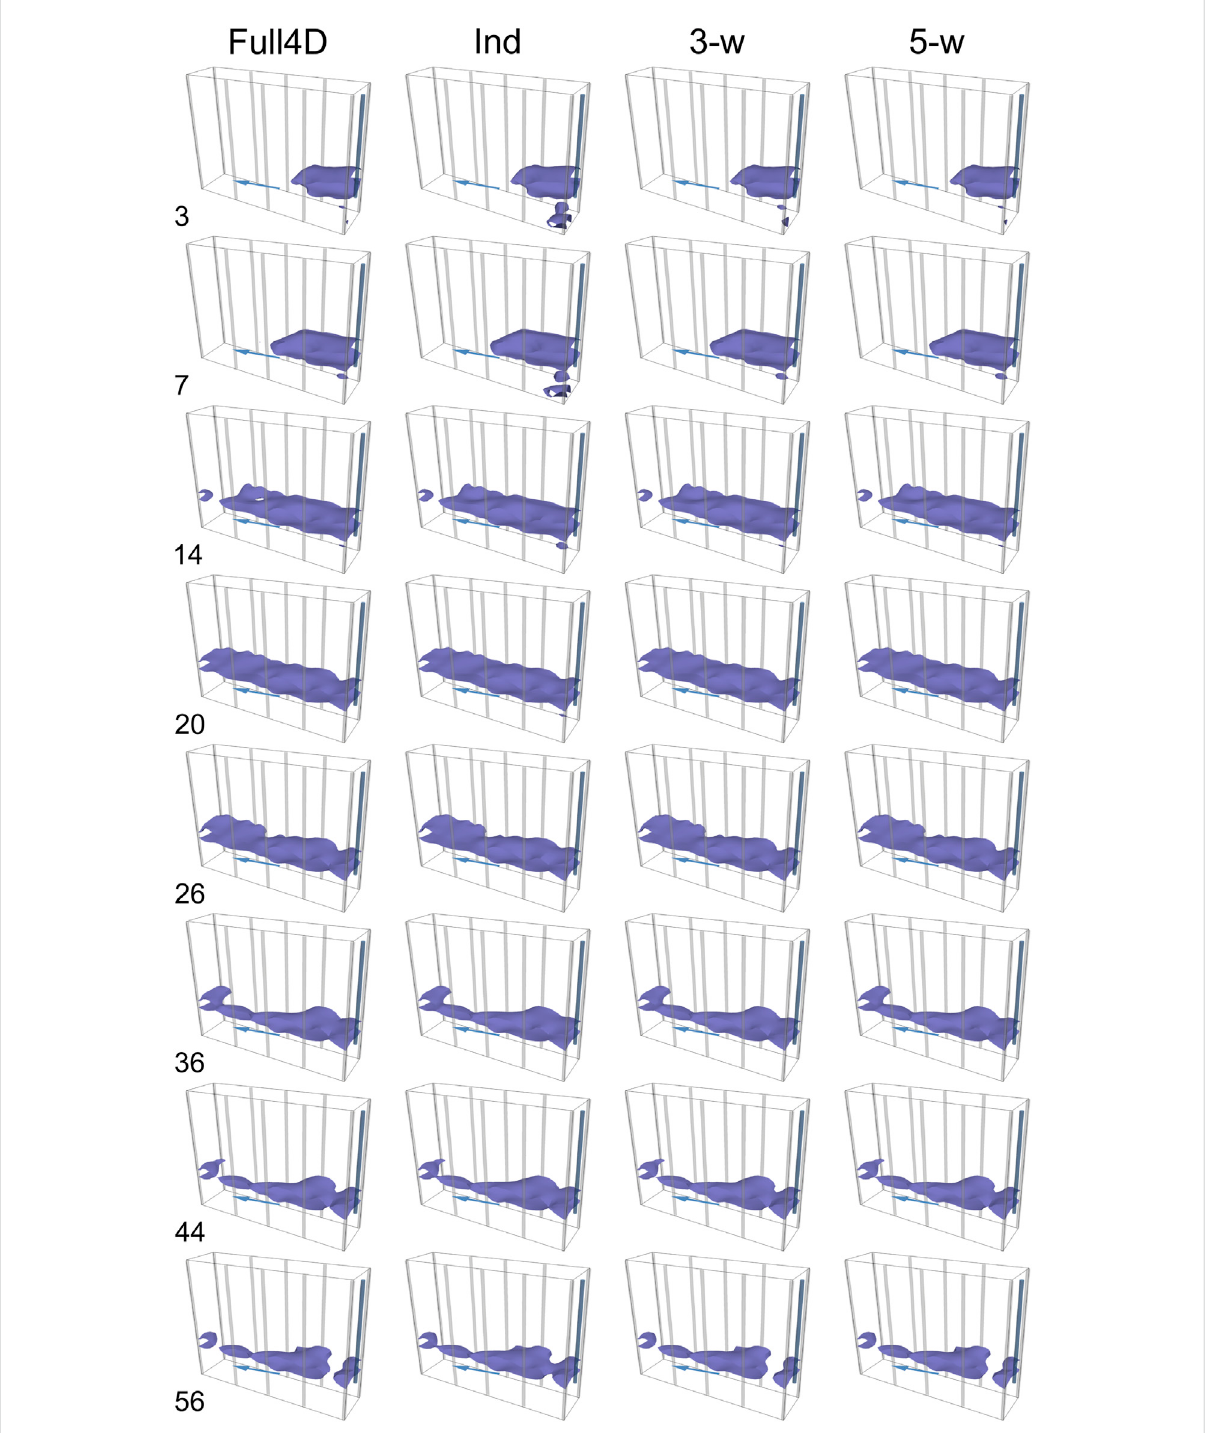
FIGURE 3 Distributions of fractional resistivity change at the former gasworks site for the full sequence 4D, independent, and windowed inversions at the timesteps indicated on the left-hand side. Isosurfaces indicate resistivity changes of − 20%. Blue arrows show groundwater fl ow direction.